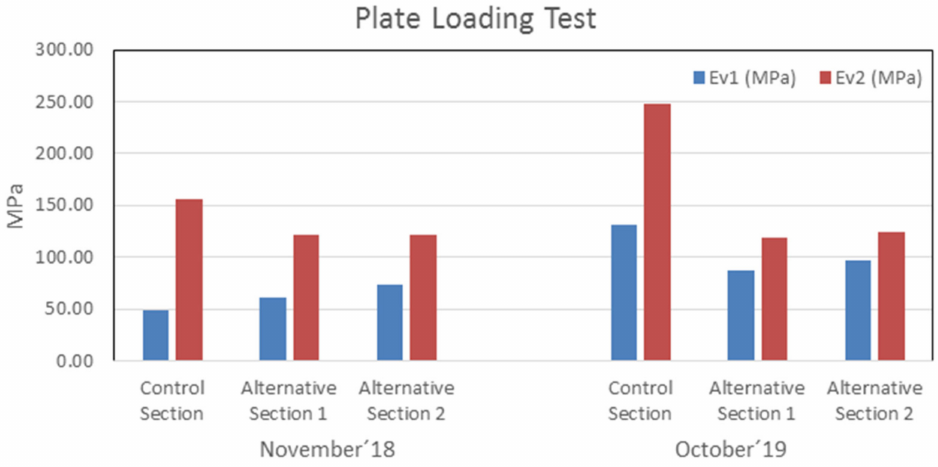
Figure 11. Value of plate loading test.